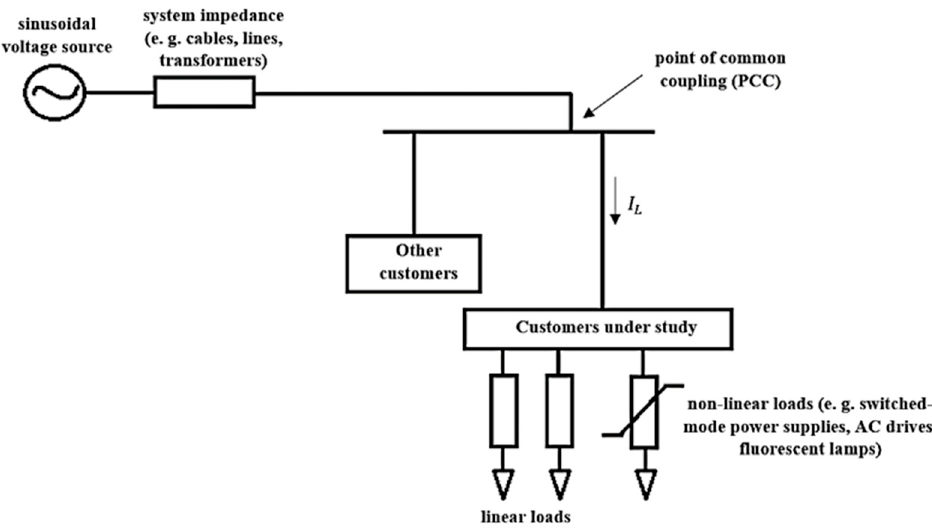
Figure 2. The typical model of the customer’s loads supply system.